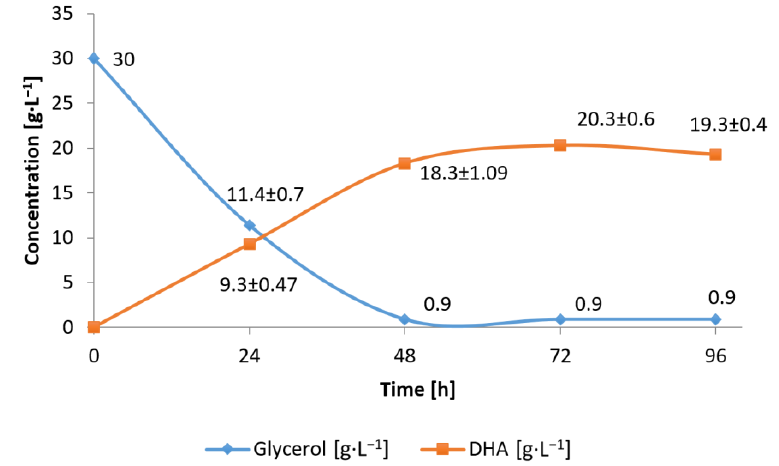
Figure 2. Time profiles of glycerol conversion and dihydroxyacetone (DHA) formation during biotransformation of 30 g · L − 1 waste glycerol with free G. oxydans cells.